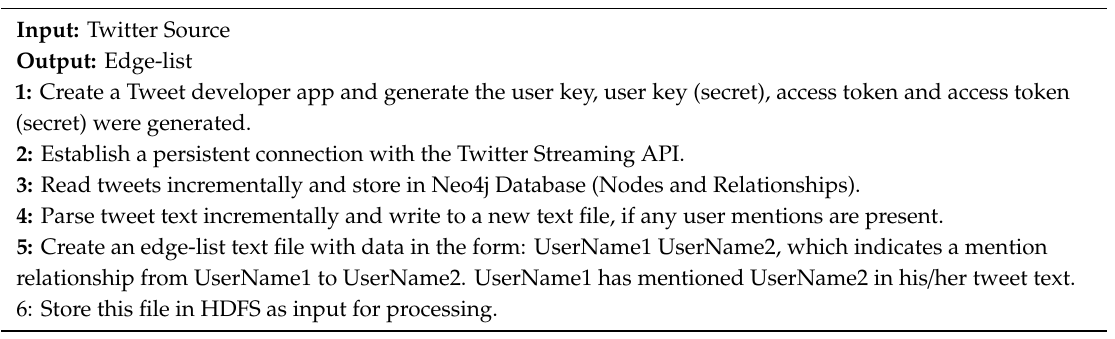
Figure 2. Architecture used for Data Collection.